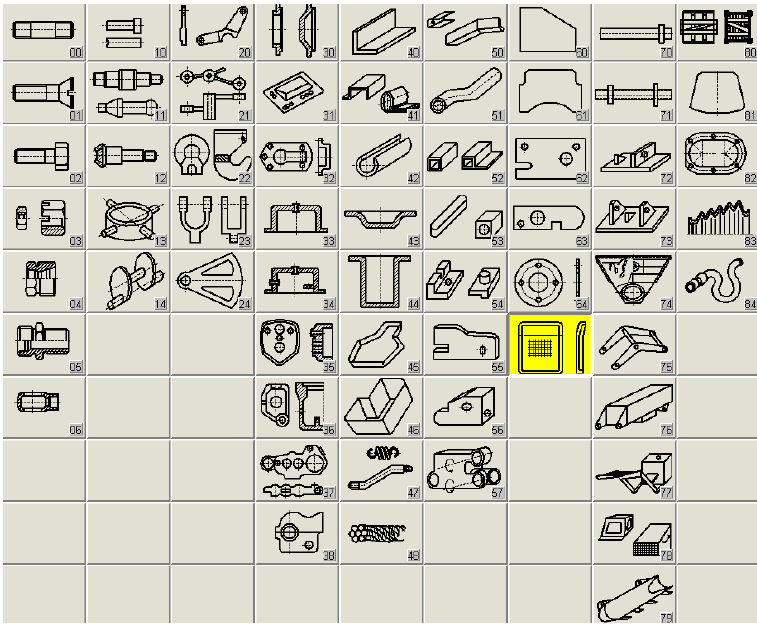
Figure 11. Example of the first level of the production item classifier–restrictions on unnecessary diversity.